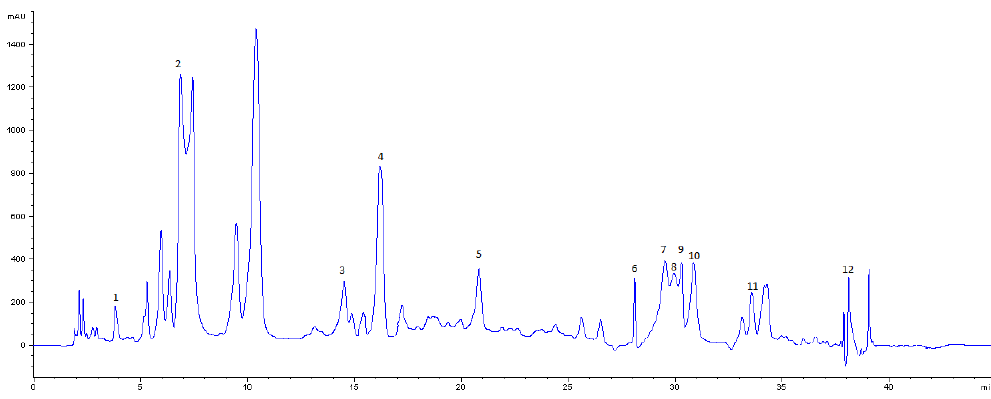
Figure 1. HPLC chromatogram of Soxhlet (SOX) leaf extract of Vitis vinifera cv. Aglianico (320 nm). Peaks: 1, gallic acid; 2, caftaric acid; 3, (+)-catechin; 4, caffeic acid; 5, benzoic acid; 6, rutin; 7, quercetin-3-O-galactoside; 8, quercetin-3-O-glucoside; 9, quercetin -3-O-glucuronide; 10, quercetin-3-O-glycoside; 11, kaempferol-3-O-glucoside; 12, quercetin. Table 2. Quantification of compounds in Vitis vinifera (cv. Aglianico) leaf extracts.